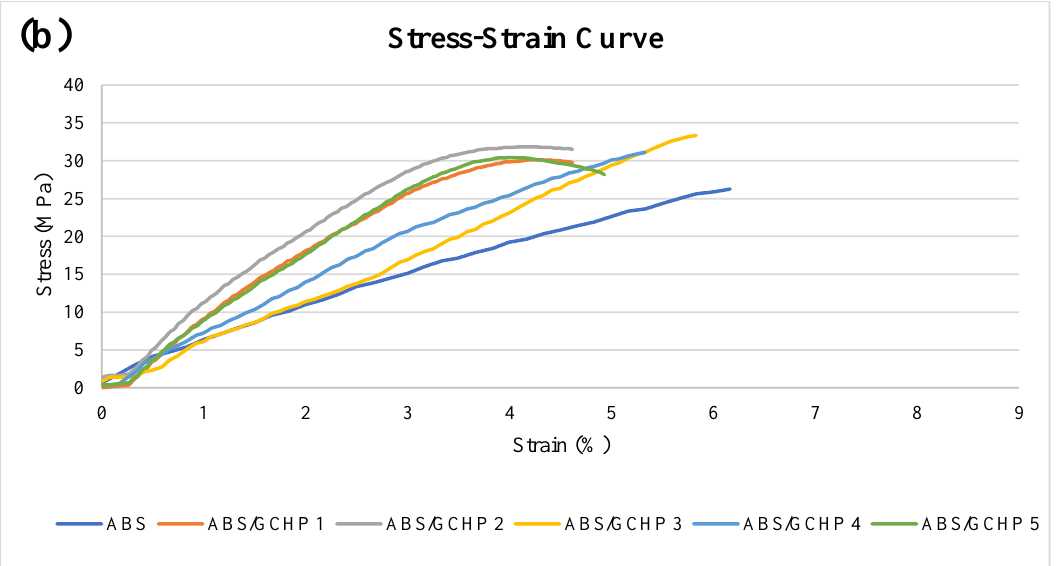
Figure 9. Comparative tensile test results for ABS/GCHP composites: ( a ) results from tensile testing with standard deviation as error bars; ( b ) stress-strain curve.